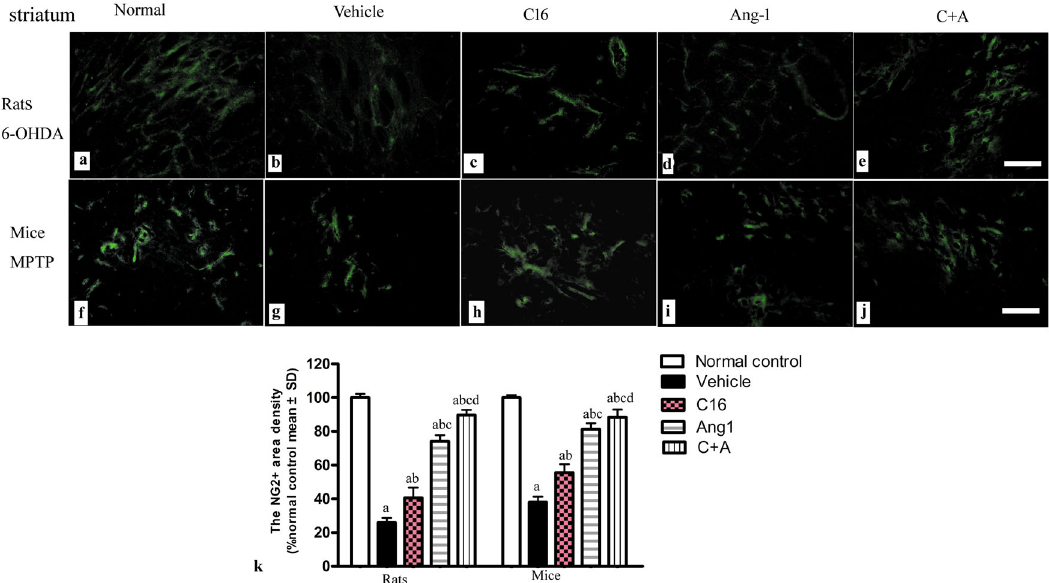
Fig. 6 C16 in combination with Ang-1 treatment restored the expression of NG2. a – j The immunostaining of NG2 + pericytes (green) in the striatum showed that the expression of NG2 was decreased in vehicle-treated PD models ( b , g ), but restored by C16 ( c , h ), Ang-1 ( d , i ), and especially the C + A treatment ( e , j ). Scale bar = 100 µm. k Quanti fi cation of the immunostaining of NG2 + pericytes. a p < 0.05 versus the normal control group; b p < 0.05 versus the vehicle group; c p < 0.05 versus the C16-treated group; d p < 0.05 versus the Ang-1-treated group. NG2, neural/glial antigen 2 proteoglycan; C16, peptide (KAFDITYVRLKF) that can selectively bind integrin α ν β 3 ; Ang-1 angiopoietin-1; PD, Parkinson ’ s